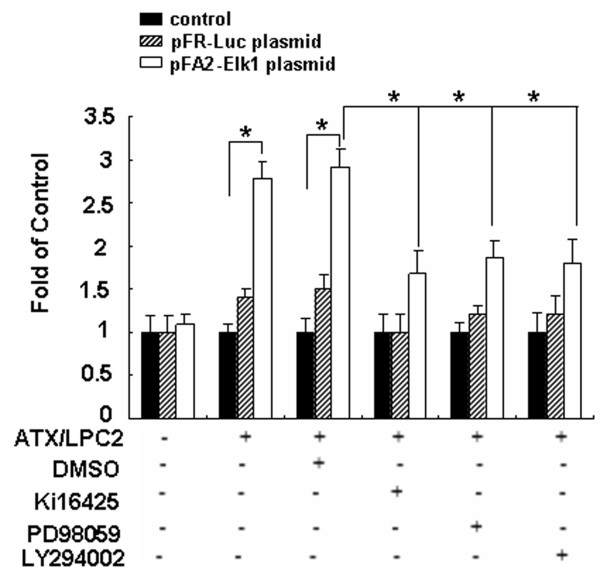
Determination of Elk-1 activities in SGC7901 cells. SGC7901 cells were transfected with either the pFR-Luc plasmid (reporter plasmid), or the pFA2-Elk1 plasmid (fusion trans-activator plasmid). Cells were then treated with ATX/LPC2, in the absence or presence of DMSO, Ki16425, PD98059, LY294002, harvested and the luciferase activity was measured. Statistical analysis was performed using Student's t test. *p < 0.05.